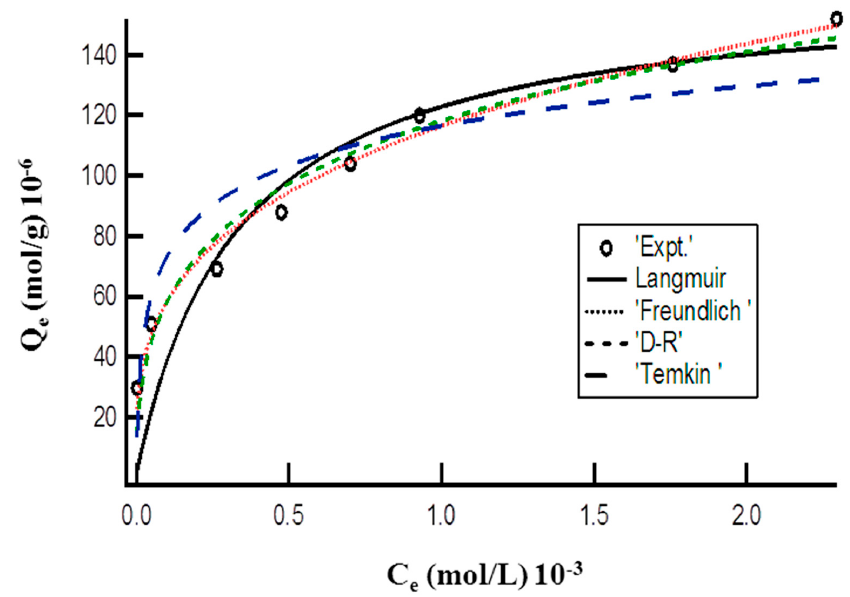
Figure 3. Plot of equilibrium concentration (C e ) vs. adsorption capacity (Q e ) representing nonlinear Langmuir, Freundlich, D-R, and Tempkin isotherms for adsorption of MO onto the DMEA-grafted AEM. Table 1. Measured isotherm parameters for MO adsorption onto the DMEA-grafted AEM by a nonlinear method.